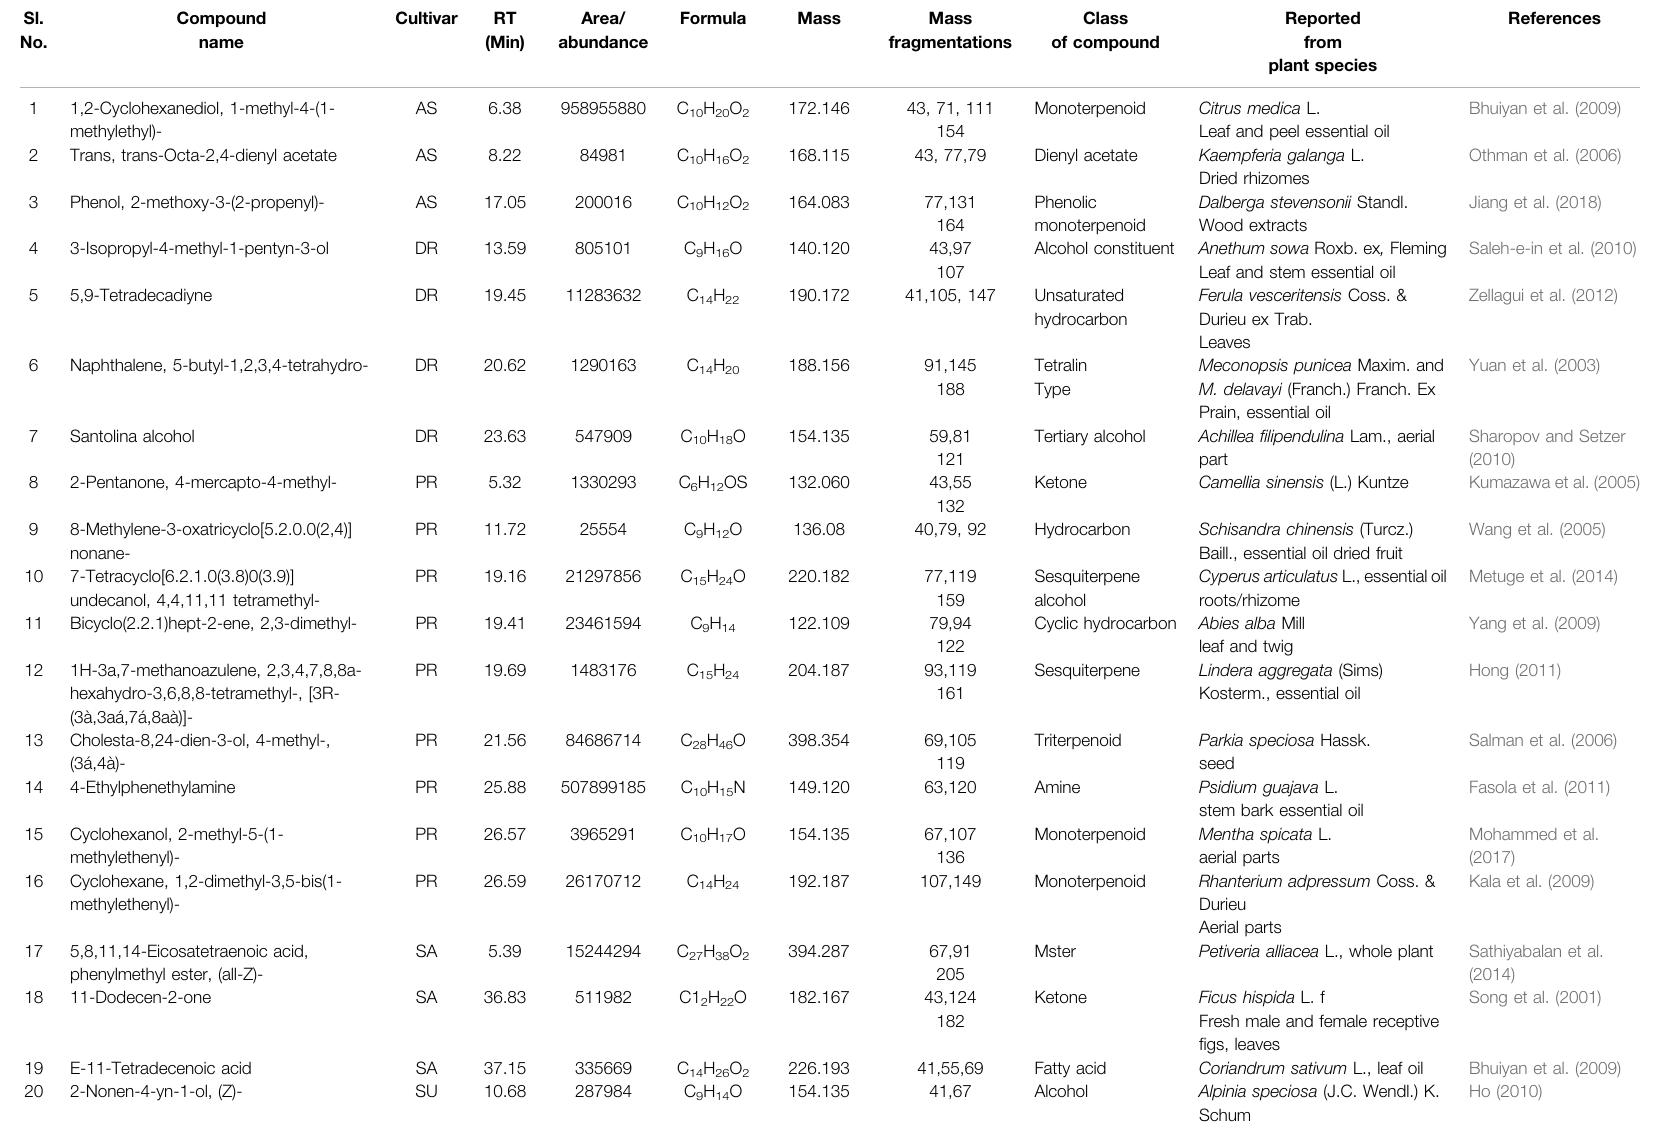
TABLE2| Cultivar-speci fi ccompoundsidenti fi ed,inoneofthesevencultivarsof Curcumalonga L.or C.aromatica Salisb.byGC-MSintheessentialoilfromrhizomes.Thestructuresofthecompounds(serialnumbersfrom1to23)are given in Figure 2 (panel numbers: 1 – 23), and this is the fi rst report of these compounds from the genus Curcuma L. These compounds, however, were reported from genus other than Curcuma L. The compounds from serial numbers 24 to 41 are already reported in Curcuma species. Structures for few compounds (serial numbers 24 – 30) are given in Figure 3 (panel numbers: 1 – 7). Abbreviations used: AS, Alleppey Supreme; DR, Duggirala Red; PR, Prathibha; SA, Salem; SU, Suguna; KAr, Kasturi Araku; KAv, Kasturi Avidi. Sl.